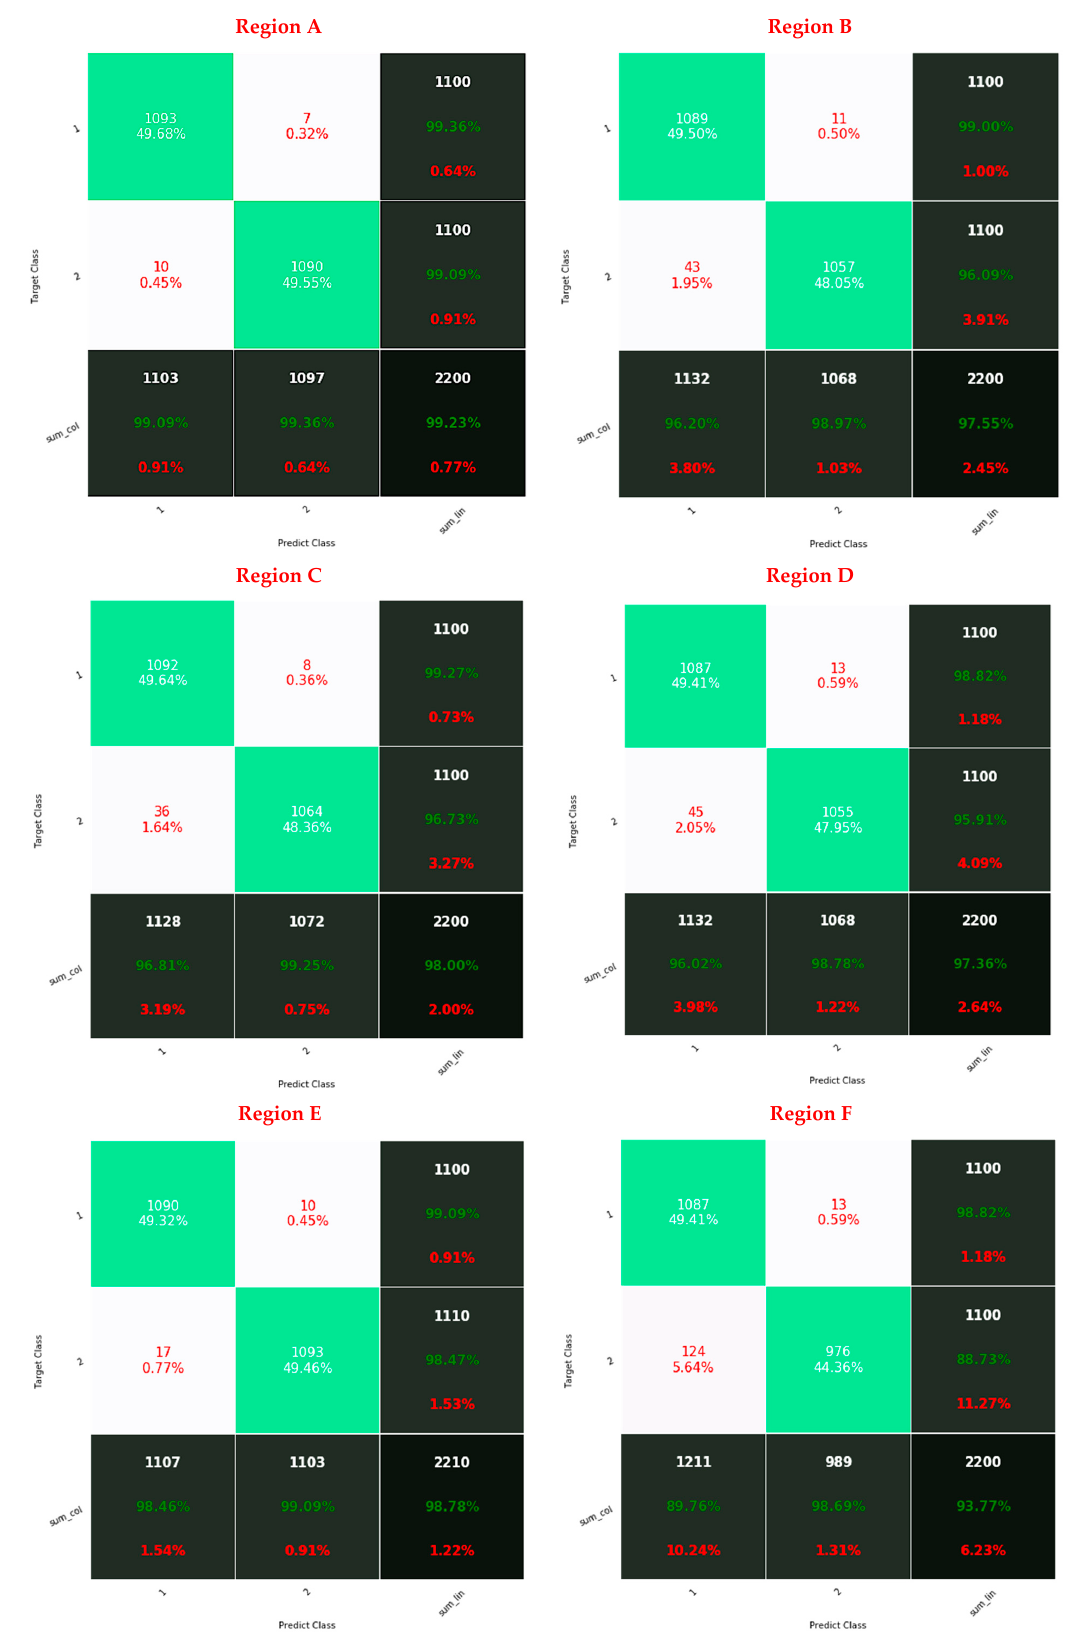
Figure 9. The proposed network accuracy for all regions for validation data.